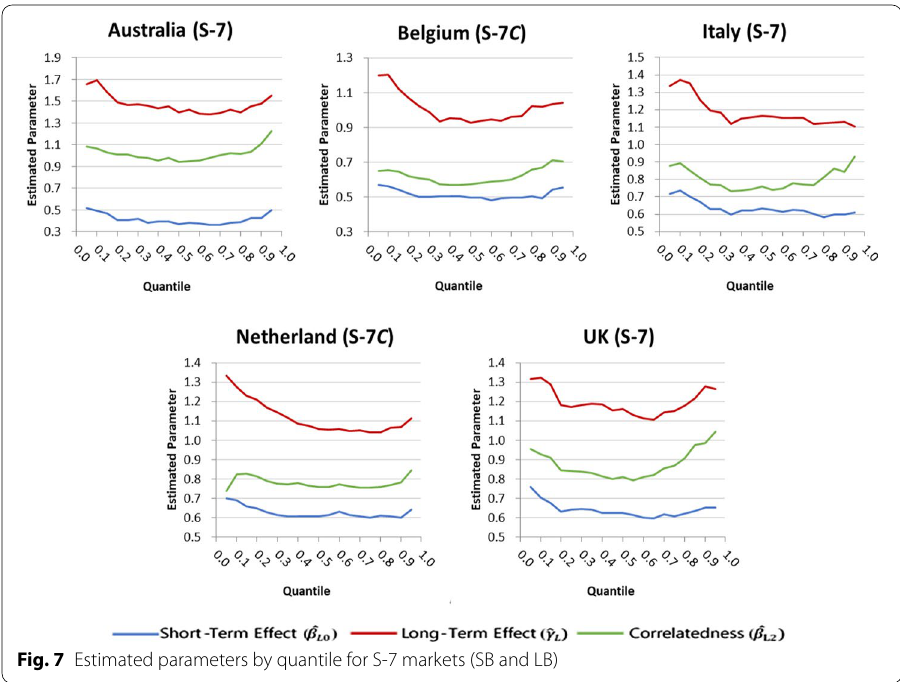
Fig. 7 Estimated parameters by quantile for S-7 markets (SB and LB)